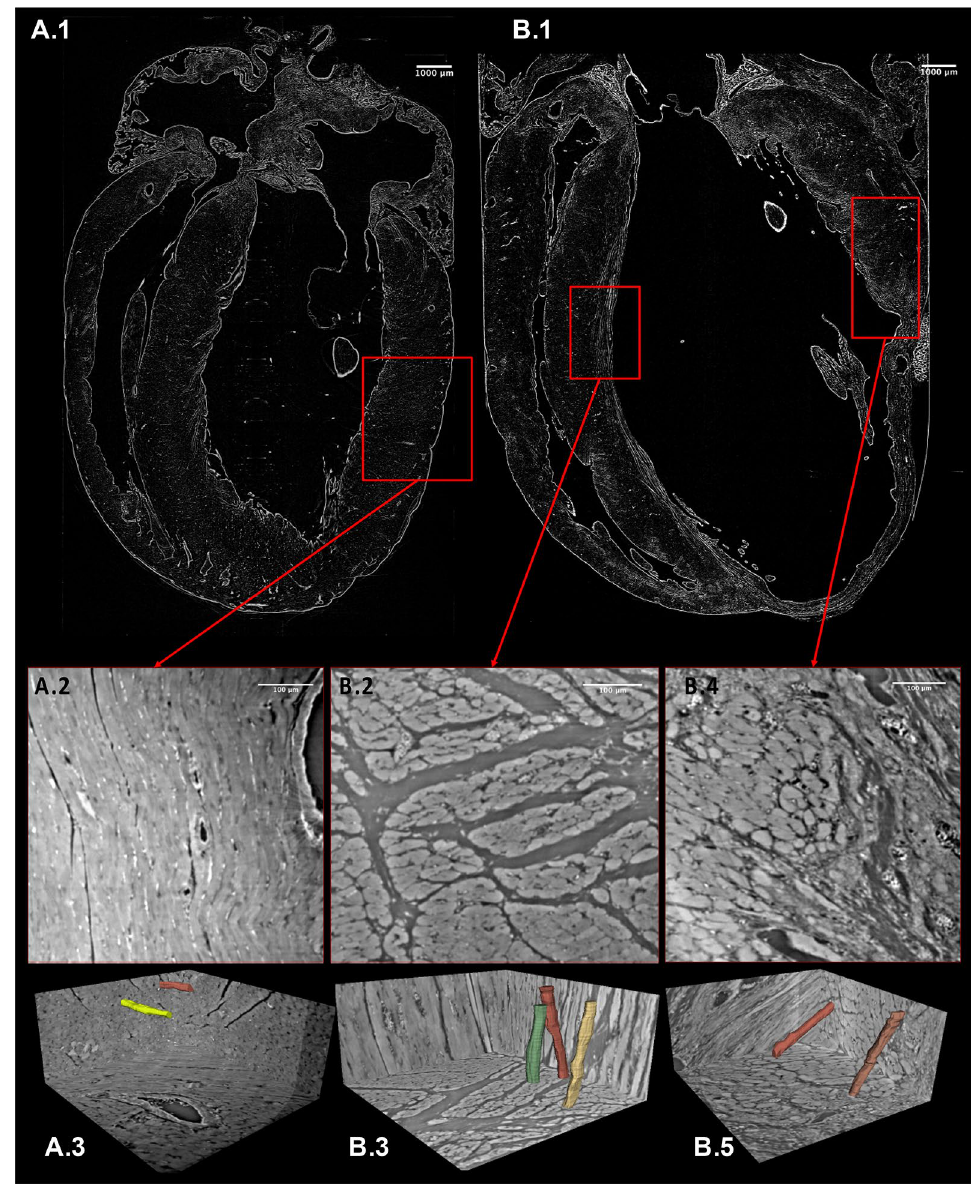
Figure 4. HR images and their location in the hearts. Upper panel: LR images of the control rat heart ( A.1 ) and a rat heart following myocardial infarction ( B.1 ), indicating the exact areas (red rectangles) from which HR images were taken. Middle panel: HR images from the selected areas, showing cardiomyocytes in both longitudinal and transversal directions. Lower panel: Three-dimensional sub-volumes of the HR datasets with segmented individual cardiomyocytes (manually delineated in 3D Slicer). HR—high resolution, LR—low